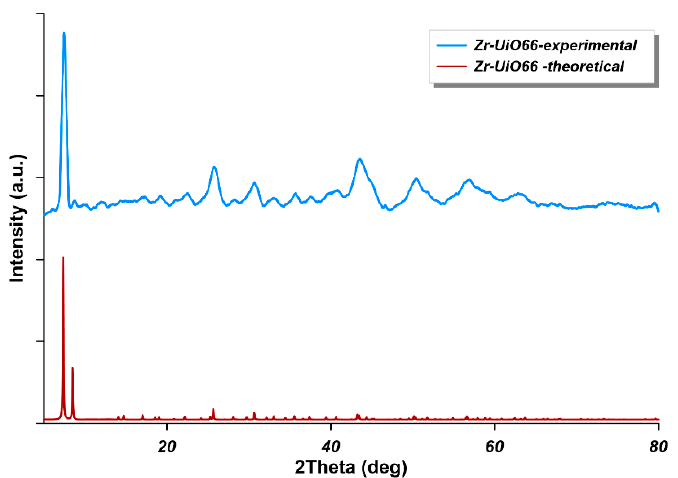
Figure 6. XRD (X-Ray diffraction) pattern of UiO-66-NH 2 (the blue curve) and the theoretical XRD pattern of UiO-66 MOF (metal-organic frameworks) (the red curve).